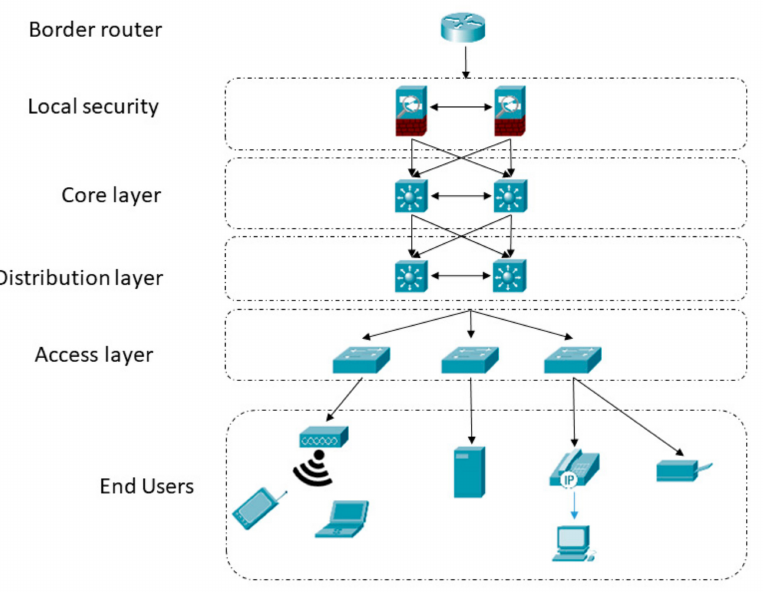
Figure 1. The layered network architecture of a university campus [24].